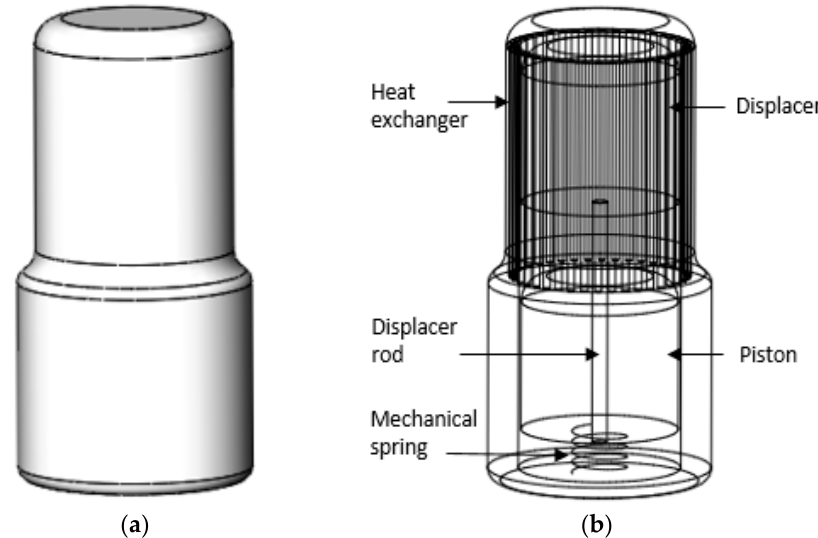
Figure 1. Schematic diagram of the gamma-type FPSE used in this study. ( a ) Casing of the FPSE; ( b ) Layout diagram of the FPSE.